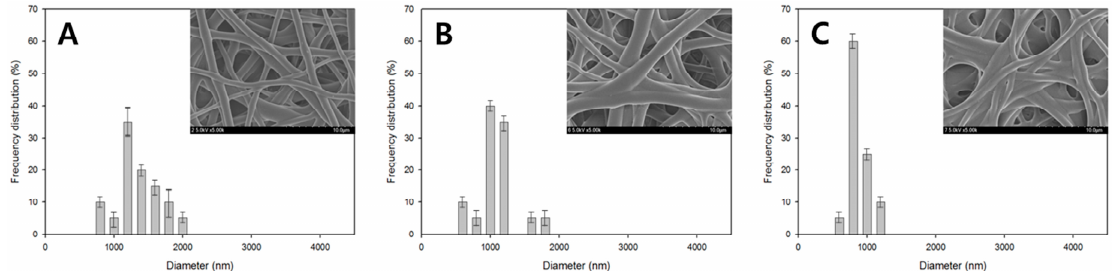
Figure 5. Fiber diameter histogram plots and FE-SEM images for saponified PVA nanofiber mats obtained at different saponification temperatures: ( A ) 25 °C; ( B ) 35 °C; and ( C ) 45 °C. The saponification solution contained NaOH (10 g), Na 2 SO 4 (10 g), and MeOH (10 g) in H 2 O (100 g) in each case. The time was kept constant at 12 h. Polymers 2016 , 8 , 376